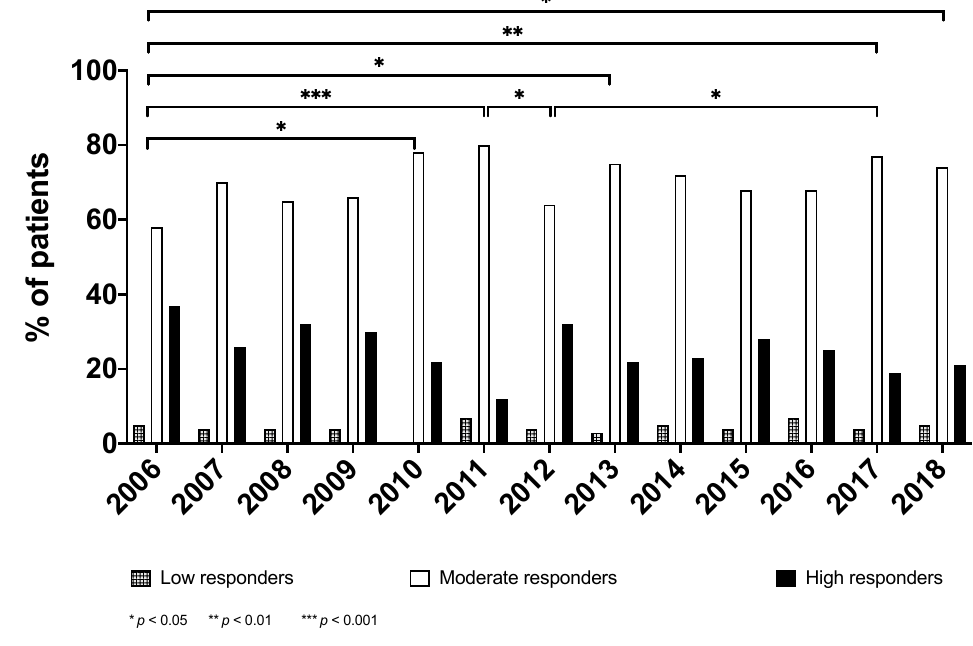
Figure 2. Clusters of responses across 13